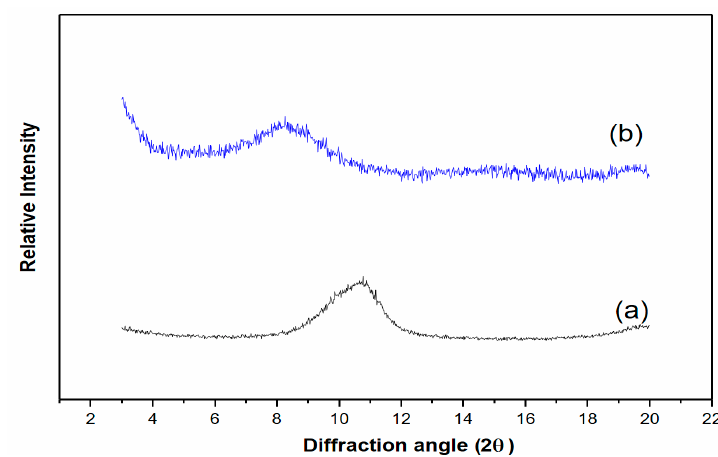
Figure 1. XRD pattern of ( a ) pristine Mg 2 Fe–LDH and ( b ) Mg 2 Fe–LDH collected after fermentation.